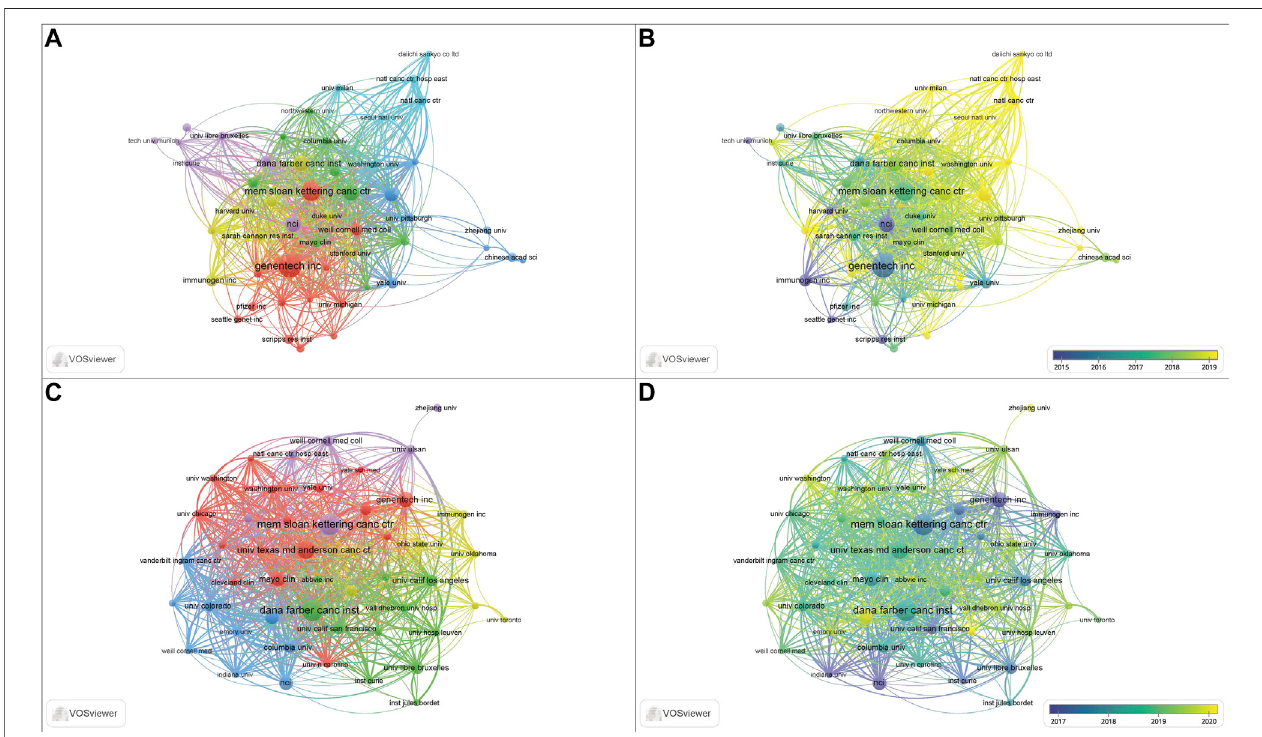
FIGURE 3 | The collaboration and overlay map of institutions for ADC research in the solid cancer fi eld. (A,B) The collaboration and overlay map of institutions for holistic ADC research, respectively. (C,D) The collaboration and overlay map of institutions for clinical ADC research, respectively.